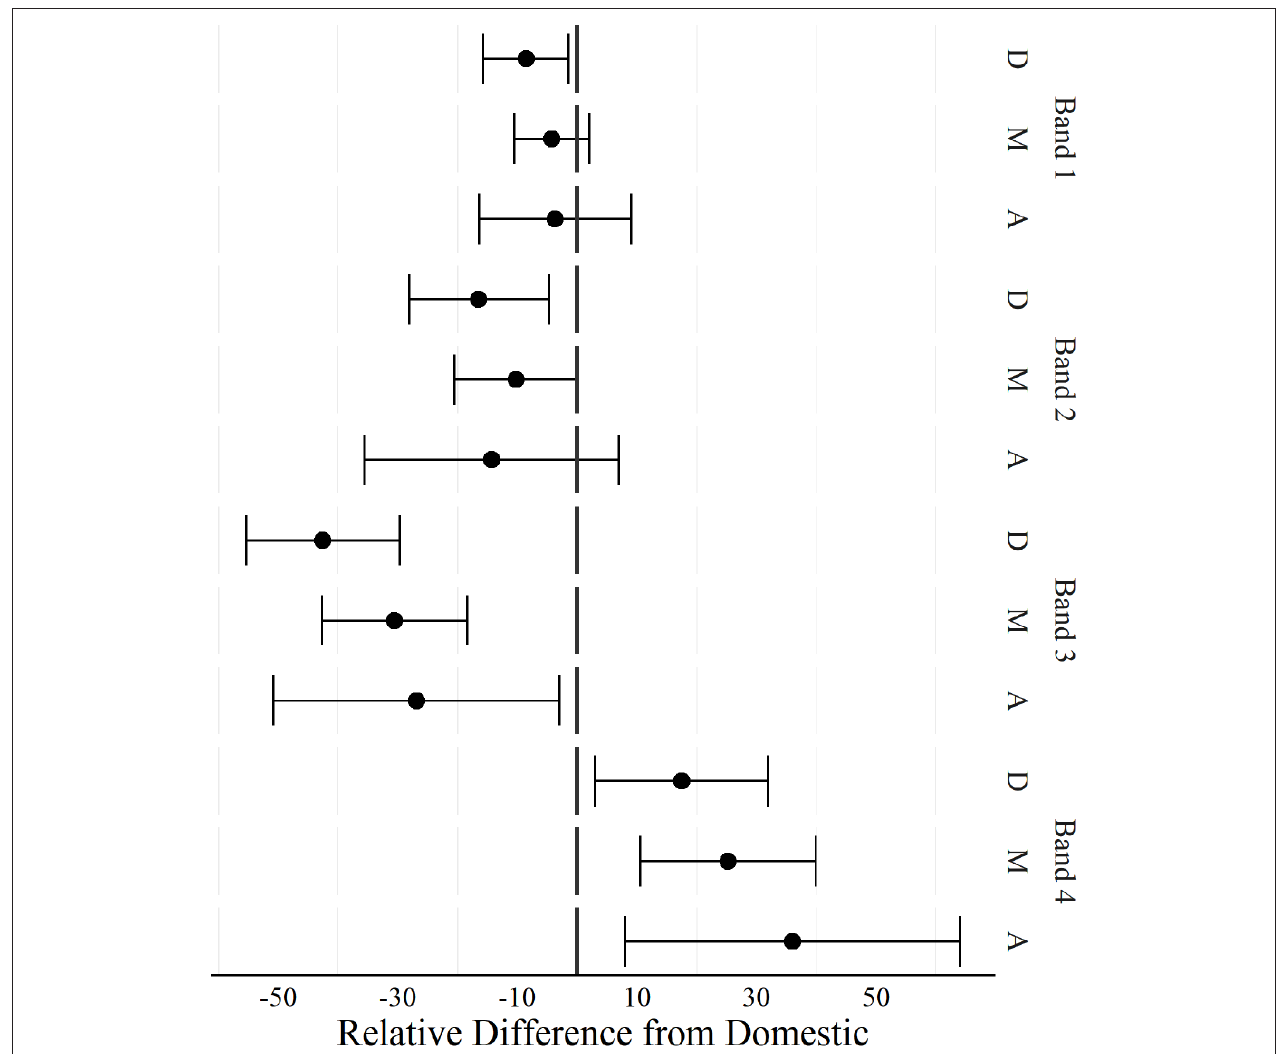
FIGURE 2 | Positional comparison of duration spent accelerating at different intensities between players competing in domestic and international women’s football matches. Band 1 (1–2 m · s − 2 ), band 2 (2–3 m · s − 2 ), band 3 (3–4 m · s − 2 ), band 4 ( > 4 m · s − 2. ). D, Defenders; M, Midfielders; A, Attackers. A negative difference indicated, domestic was greater than international, a positive difference indicated international was greater than